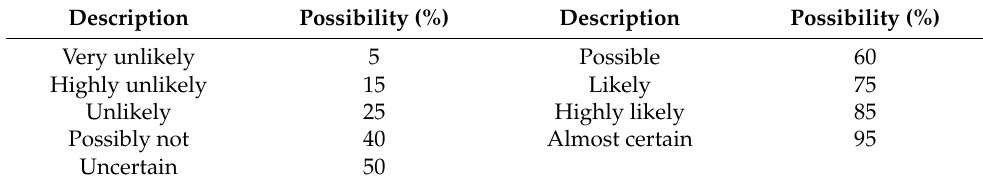
Table 1. Subjective probability estimation scale [4].